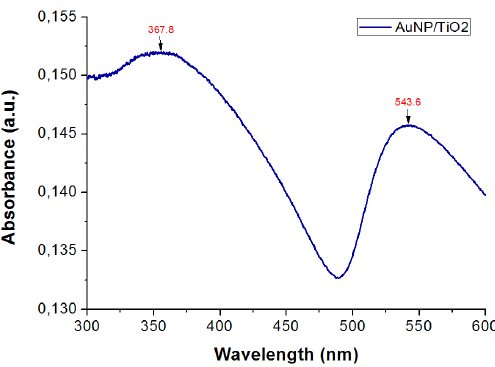
Figure 3. UV–vis spectrum of a titania nanofibrous network after gold decoration (TiO 2 : 367.8nm; Au NPs: 543.6nm).